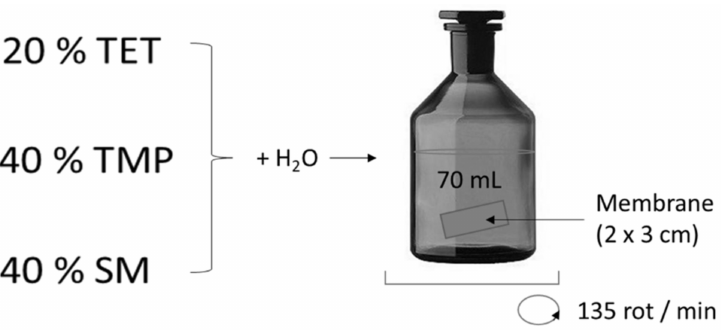
Figure 2. The membrane sorption of the antibiotics—tetracycline (TET), sulfamethoxazole (SM), and trimethoprim